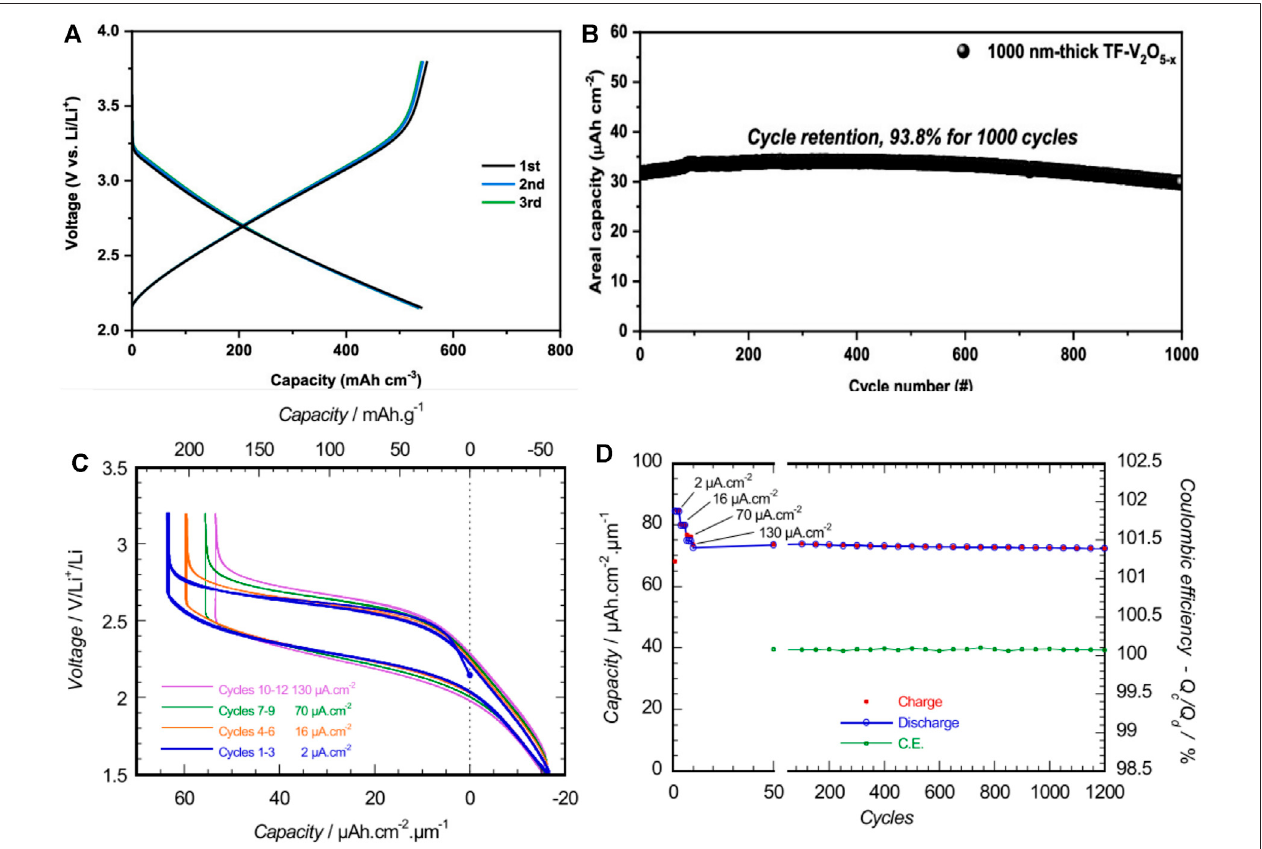
FIGURE 5 | (A) Galvanostatic discharge − charge pro fi le of V 2 O 5-x /Lipon/Al 2 O 3 (1 nm)/Li ASTB and (B) long-term stability data of the cell at 2 ° C. Reprinted with permission from Xiao et al. (2021). © 2021 ACS. Galvanostatic cycling of (C) Li 1.2 TiO 0.5 S 2.1 (R1) thin fi lms in ASTB at various current densities (130 µAh cm − 2 ∼ 2C rate), and (D) the respective evolution of both the volumetric capacity and the Coulombic ef fi ciency. Reprinted with permission from Dubois et al. (2017). © 2017